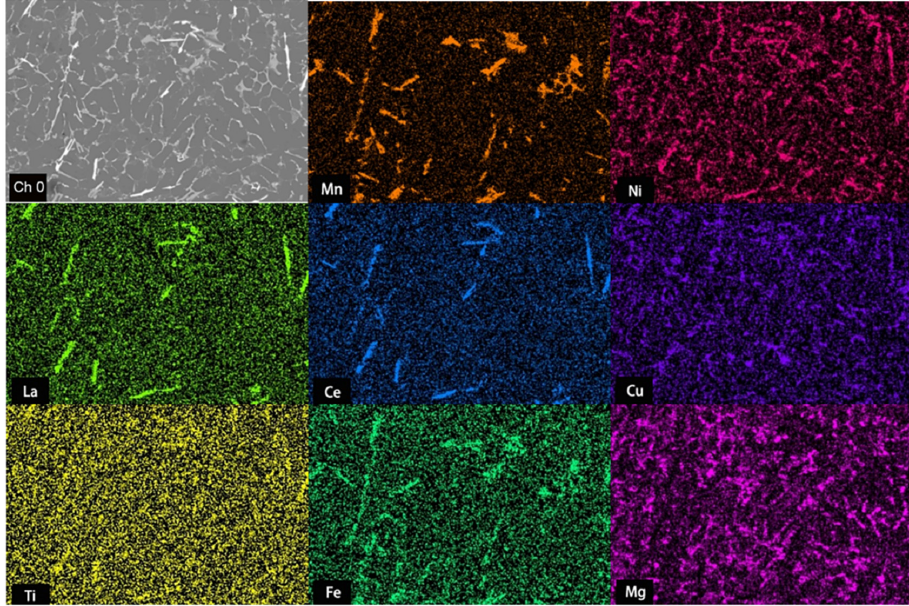
Figure 5. EDS element mapping for the 1% (Ce + La) sample.